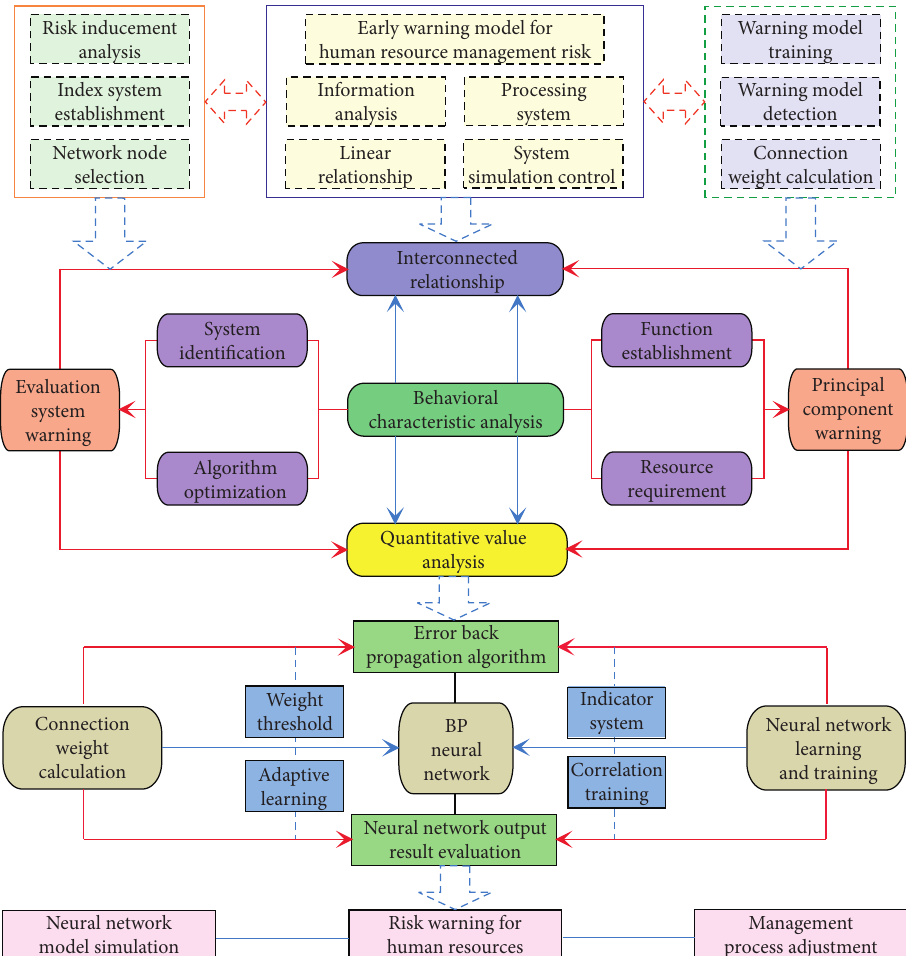
Figure 2: Analysis and simulation framework of the early warning model for human resource management risk based on the BP neural